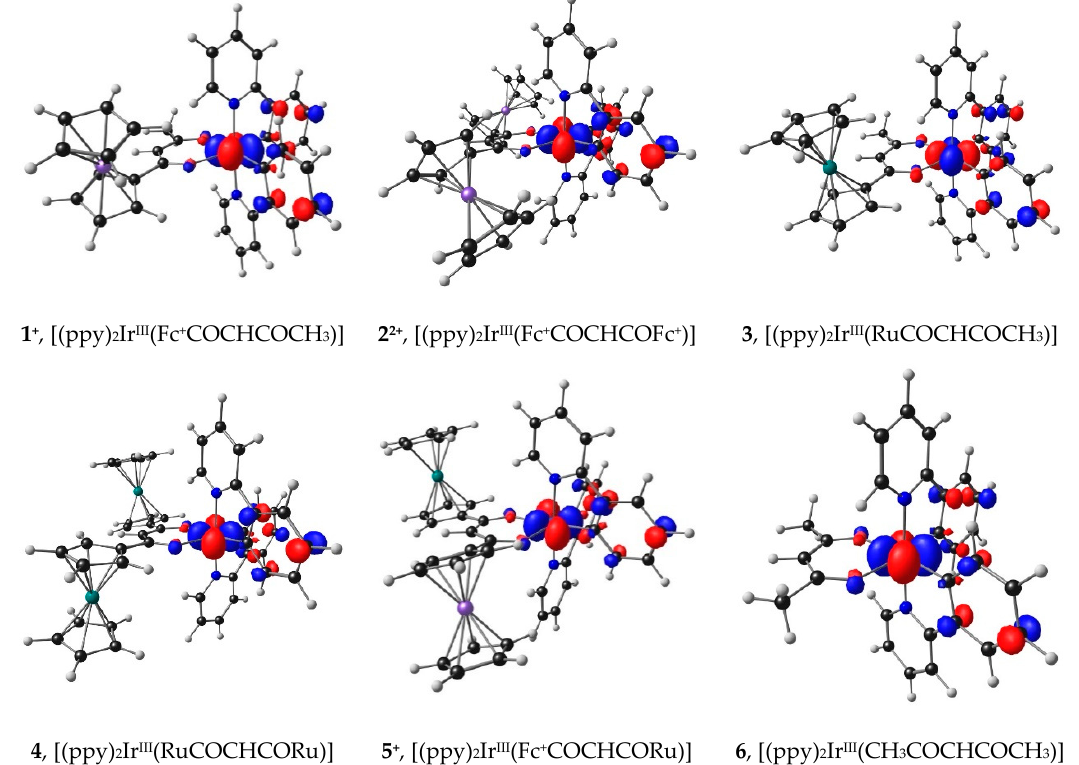
Figure 5. B3LYP / 6-311G(d,p) / def2-TZVPP(SDD) calculated HOMOs of molecules involved in the Ir III oxidation. Calculations was done using DCM as solvent. A contour of 0.06 eÅ -3 was used for the MO plots. Gas phase calculated HOMOs look similar and are provided in the Supporting Information Figure S2.